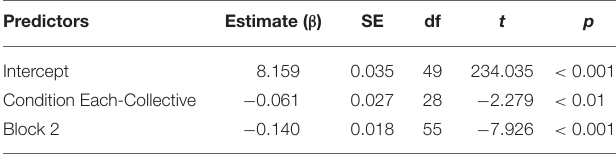
TABLE 4 | Overview of the model comparing the response times of the “no” responses in conditions The-Distributive and Each-Collective, with reference levels: Condition: “The-Distributive,” and Block: 1.